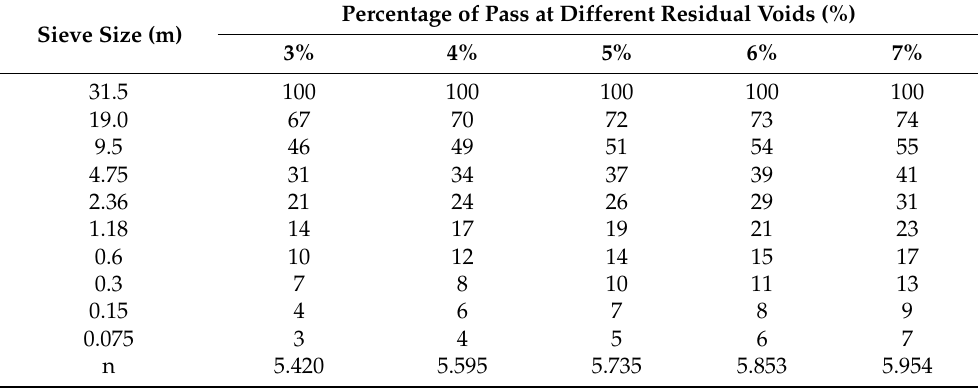
Table 4. Particle size distribution design with differing residual